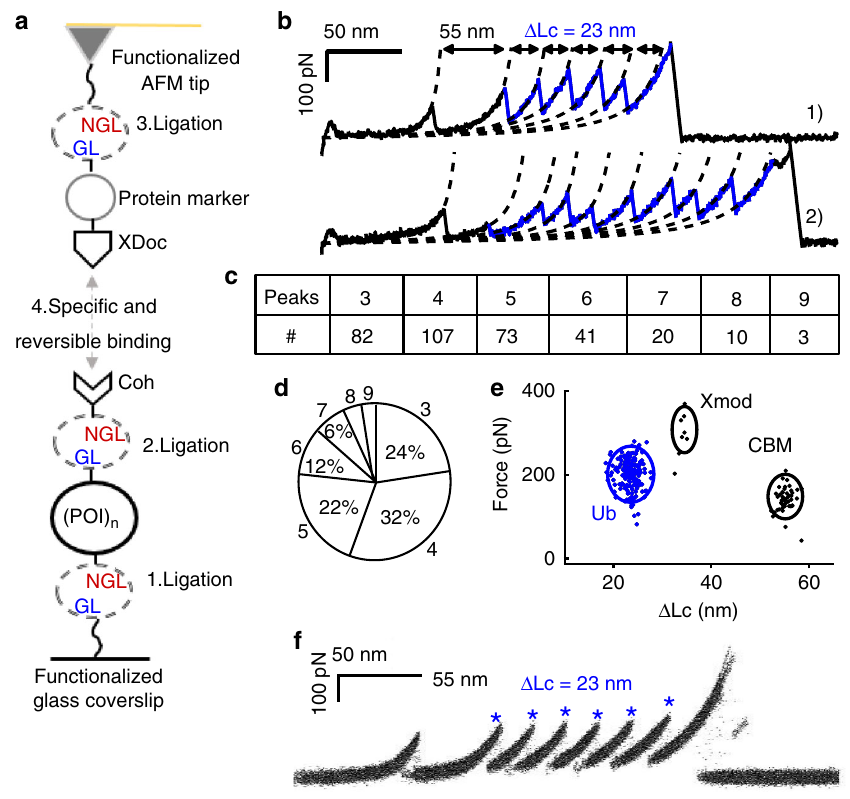
Fig. 3 The OaAEP1-dependent polyprotein immobilization veri fi ed by single-molecule AFM. a The schematic shows that OaAEP1 facilitates a covalent anchoring of (poly)protein on a glass surface as well as a speci fi cally probing by an XDoc-functionalized AFM tip. b Representative curves of (Ub) n in the speci fi c attachment showed a high detachment force from the Coh-XDoc interaction and more unfolding peaks. c , d The statistical analysis of the (Ub) n indicated the number of curves with a speci fi c number of ubiquitin peaks. Most curves showed the number of Ub unfolding peaks between three and six (>90%). e The scatter plot shows the relationship between unfolding/rupture force and Δ Lc for (Ub) n , Xmodule of the XDoc ( Δ Lc = 35 nm), and the CBM. f The overlay of all curves with CBM unfolding fi rst show the complete unfolding of the polyprotein (Ub) 6 using the OaAEP1-dependent polyprotein immobilization method ( n = 52). The covalent immobilization with a high detachment force enables the complete unfolding of all subdomains in the polyprotein. Source data of Fig. 3e are provided as a Source Data fi